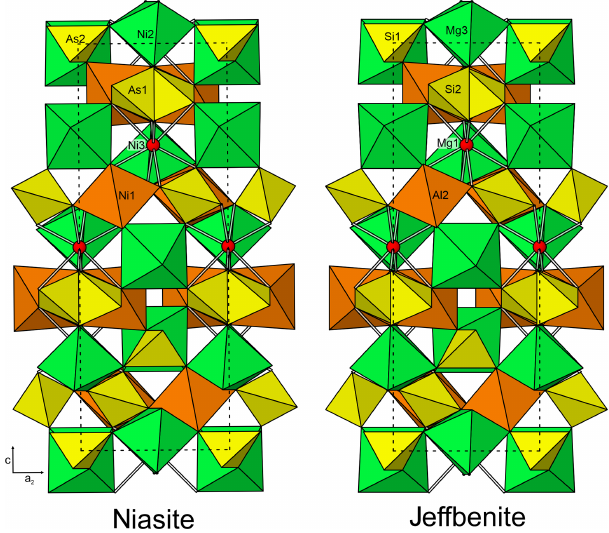
Figure 6. Crystal structures of niasite and jeffbenite. Note that the jeffbenite cell has been shifted by one-half along c to correspond to the niasite cell.